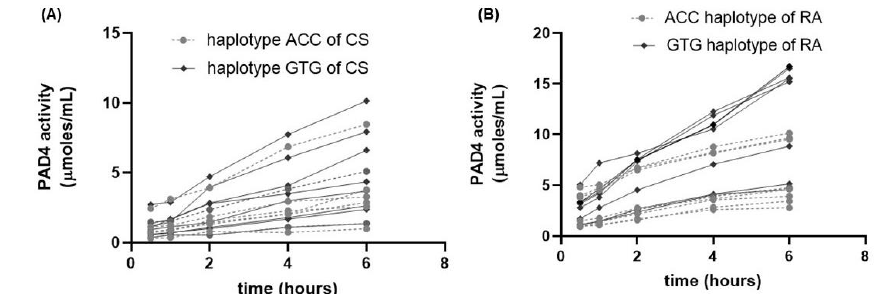
Figure 4. Effect of incubation time on the PAD4 activity from lysates of leukocytes from CS and RA. ( A ) Changes in µmoles/mL for each CS; ACC haplotype carriers are represented in the gray lines, while CS with the GTG haplotype are represented in the black lines. ( B ) Changes in µmoles/mL for each RA patient. RA patients carrying the ACC haplotype are represented by gray lines, while RA patients with the GTG haplotype are represented with black lines.